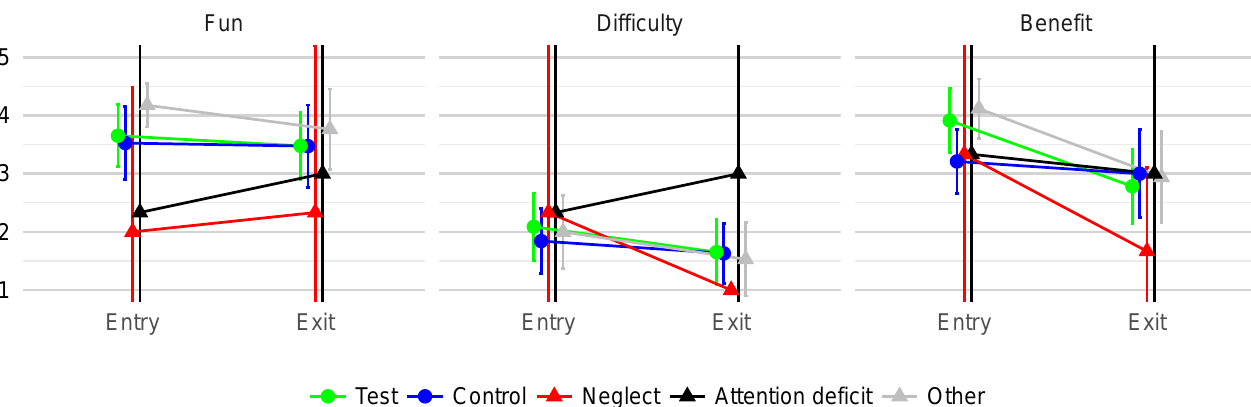
Figure 2. Averages of Likert scores of perceived fun , difficulty , and benefit with 0.95 confidence interval error bars during Entry and Exit sessions from the different participant (Test, Control) and patient groups (neglect, attention deficit, and others from the test group)